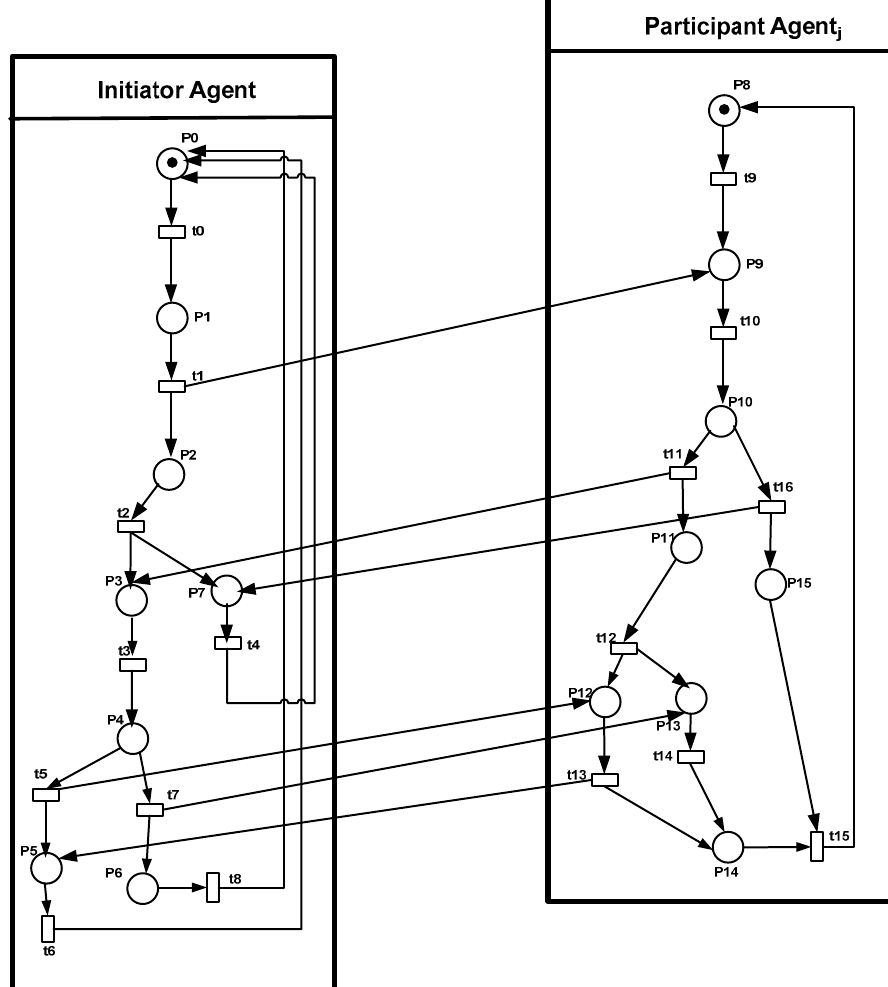
Figure 5. Formal distributed task allocation with Petri net. Table 1. The meaning of the main transitions related to Figure 5.